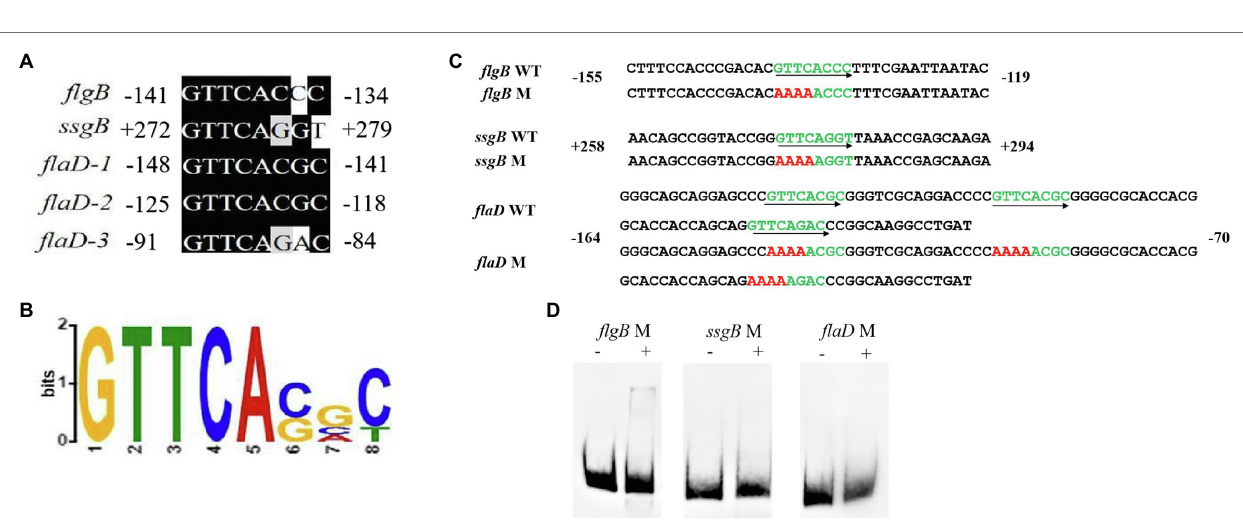
were identified in the genome of the A. pretiosum X47 strain (GenBank Accession number CP023445; Zhong et al., 2019). RNA-seq indicated that transcription of most flagellum-related